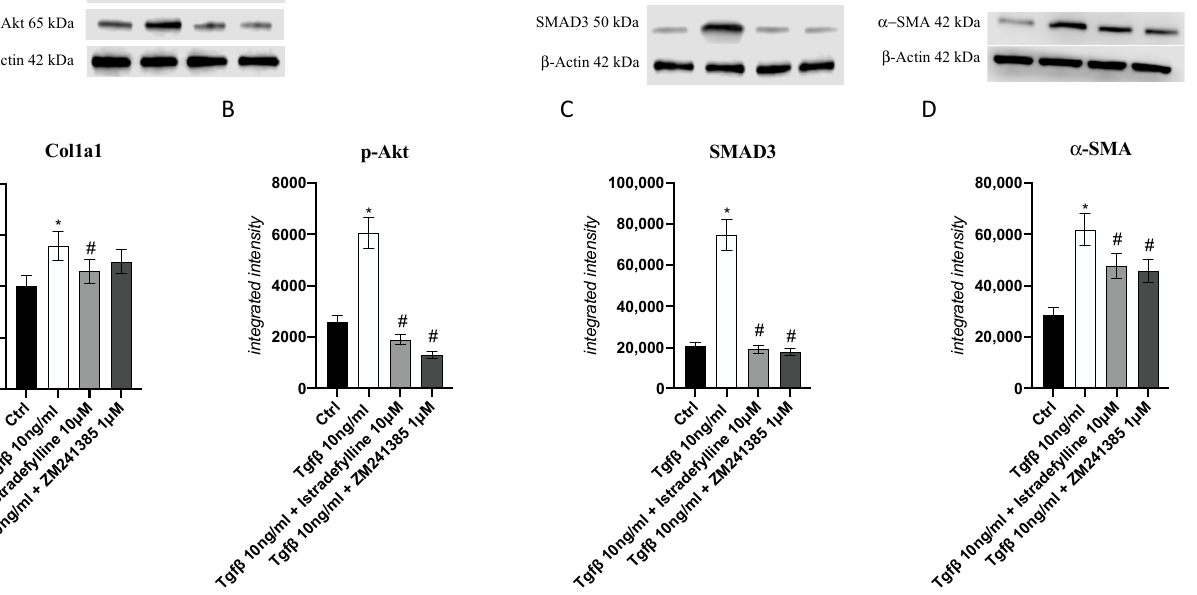
Figure 4. Graphs representing Col1a1 ( A ), p-Akt ( B ), SMAD3 ( C ) and α -SMA ( D ) protein expression in IM-HCF cells evaluated by Western blotting. The data are expressed as the means and SDs of five experiments. * p < 0.05 vs. CTRL; # p < 0.05 vs. TGF- β .